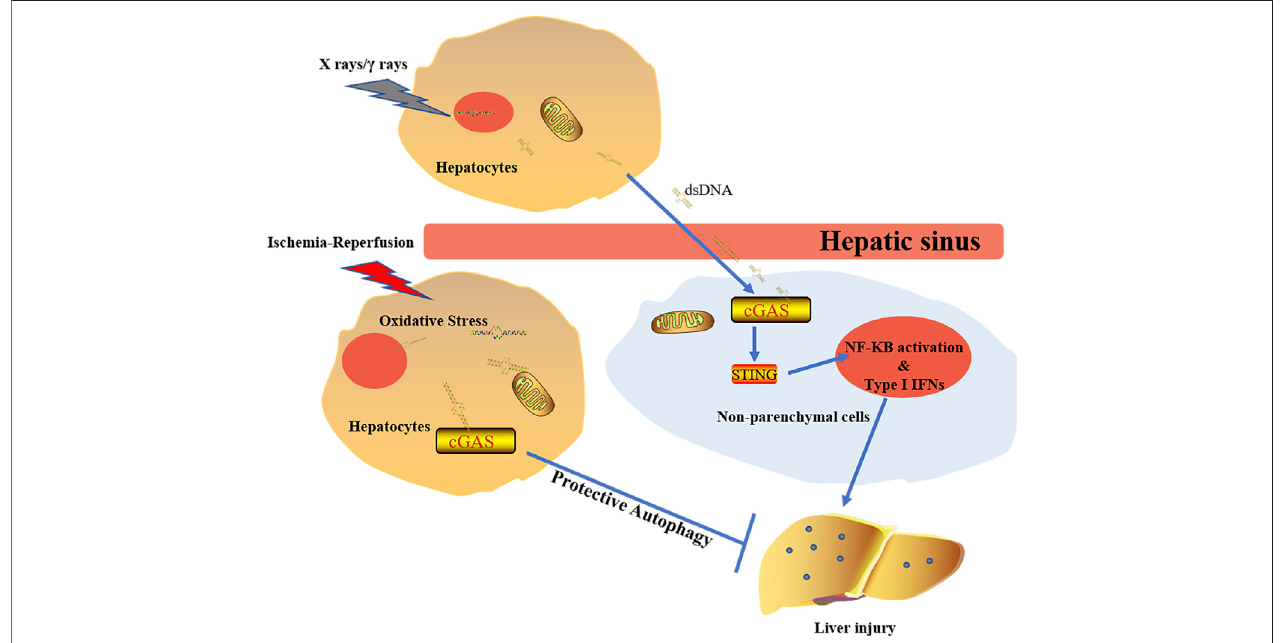
FIGURE 5 | The diverse effects of cGAS doses on liver under different stimulations. The activation of cGAS-STING-IFN1 pathway induced by X rays/ γ rays promotes development of RILD. Under the circumstance of ischemia-reperfusion, activated cGAS plays protective roles via regulating autophage in a STING- independent